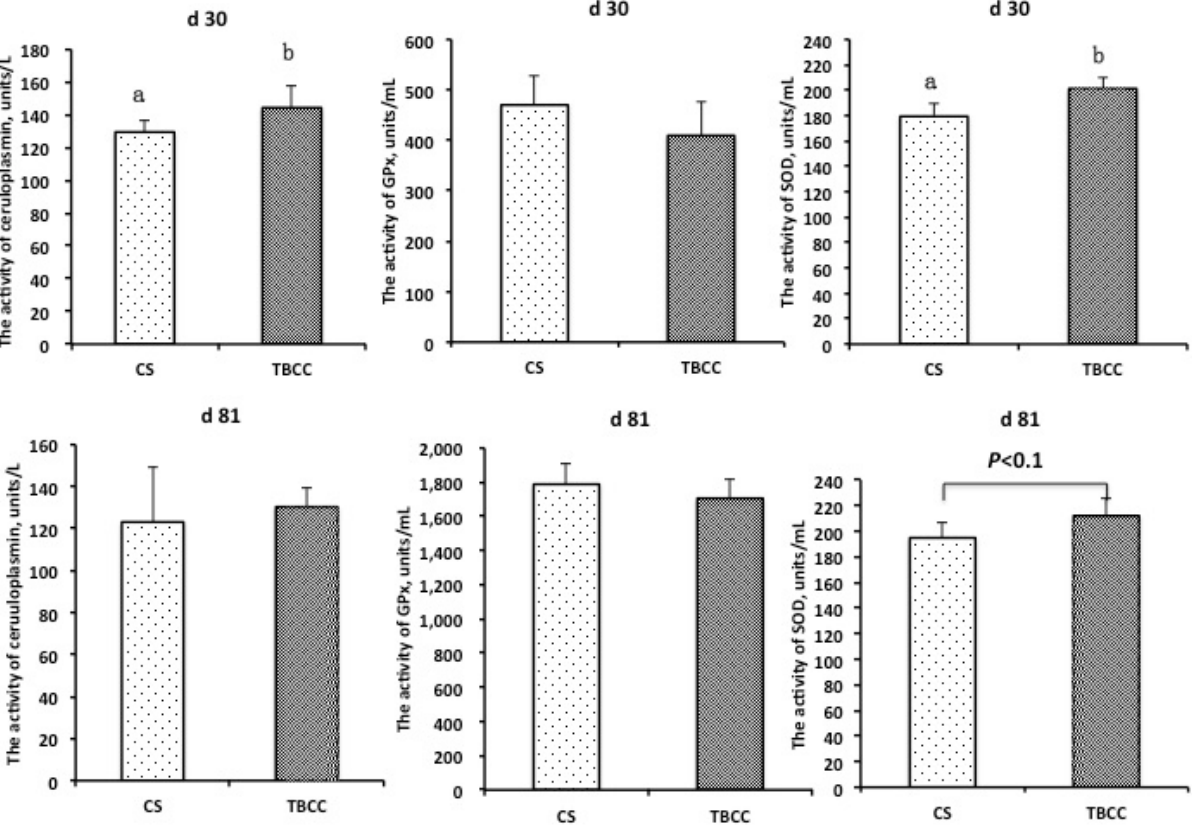
Figure 1. Effect of copper sulfate (CS) and tribasic copper chloride (TBCC) on serum activities of ceruloplasmin, glutathione peroxidase (GPx), and superoxide dismutase (SOD) in pigs. a,b Means with different superscript letters represent differences between the CS diet and the TBCC diet